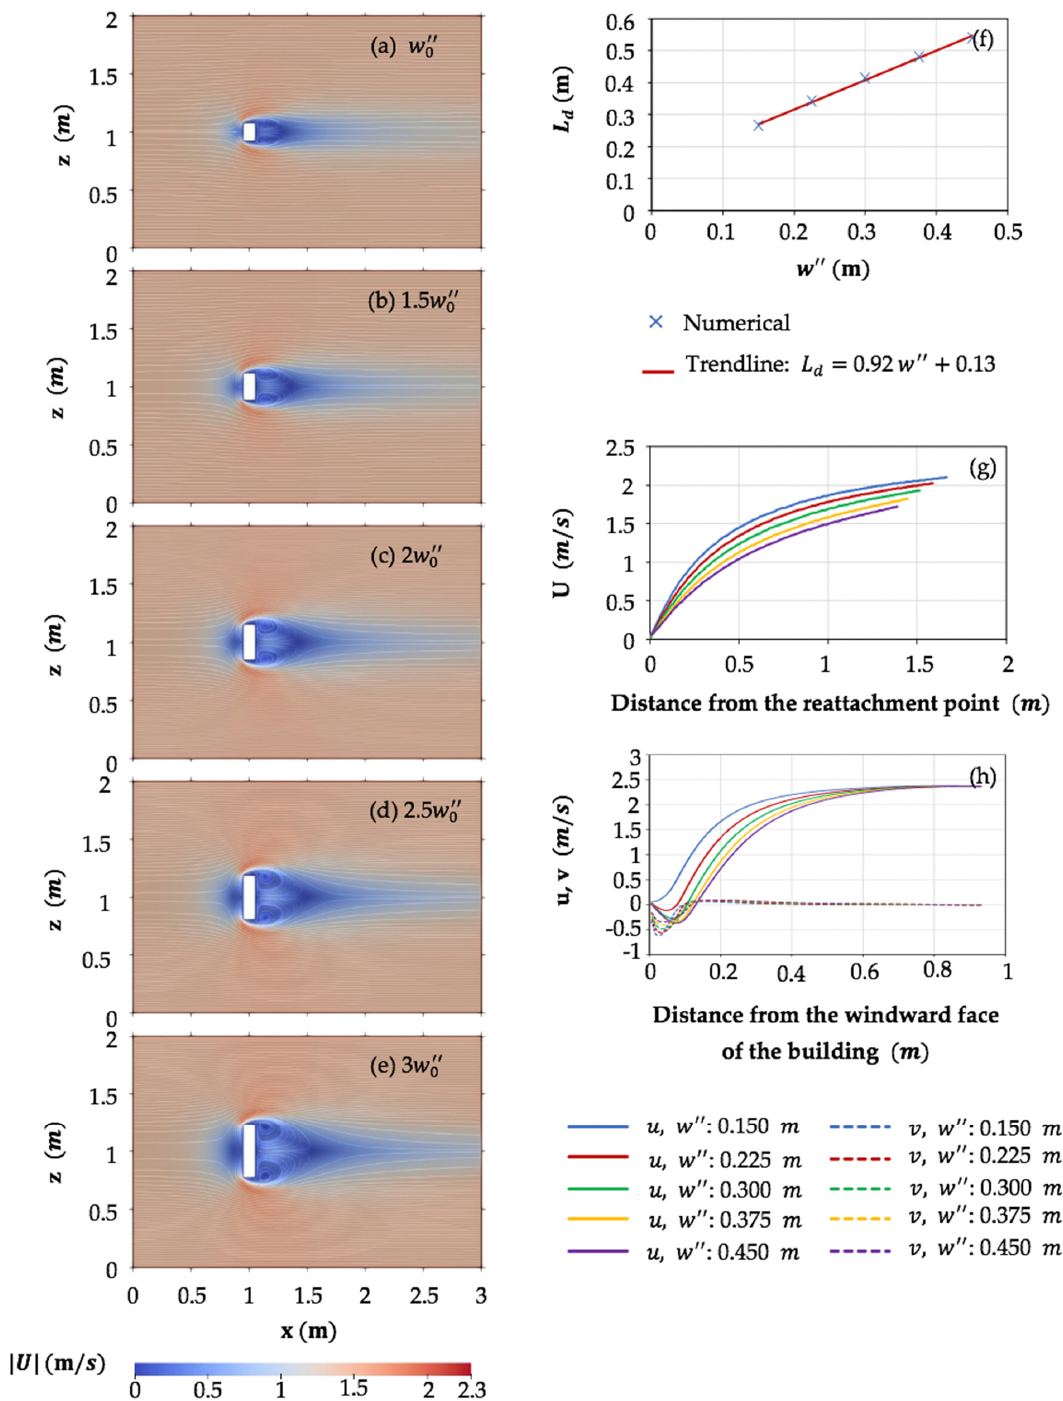
Figure 6. The impact of building width on ( a – e ) wind velocity magnitude (color) and direction (streamlines), ( f ) length of the downwind recirculation region, L d , just behind the leeward face of the building along the centerline, ( g ) wind velocity magnitude downstream of the building after flow reattachment along the centerline, and ( h ) streamwise, u , and vertical wind velocity components, v , upstream of the building along the centerline. Results are derived for a horizontal near-surface plane, y = 0.0125 m. The building length and height are l (cid:48)(cid:48) and h (cid:48)(cid:48) , respectively. The building width, w (cid:48)(cid:48) , is 0 0 varied as w (cid:48)(cid:48) , 1.5 w (cid:48)(cid:48) , 2 w (cid:48)(cid:48) , 2.5 w (cid:48)(cid:48) , and 3 w (cid:48)(cid:48) 0 0 0 0 0